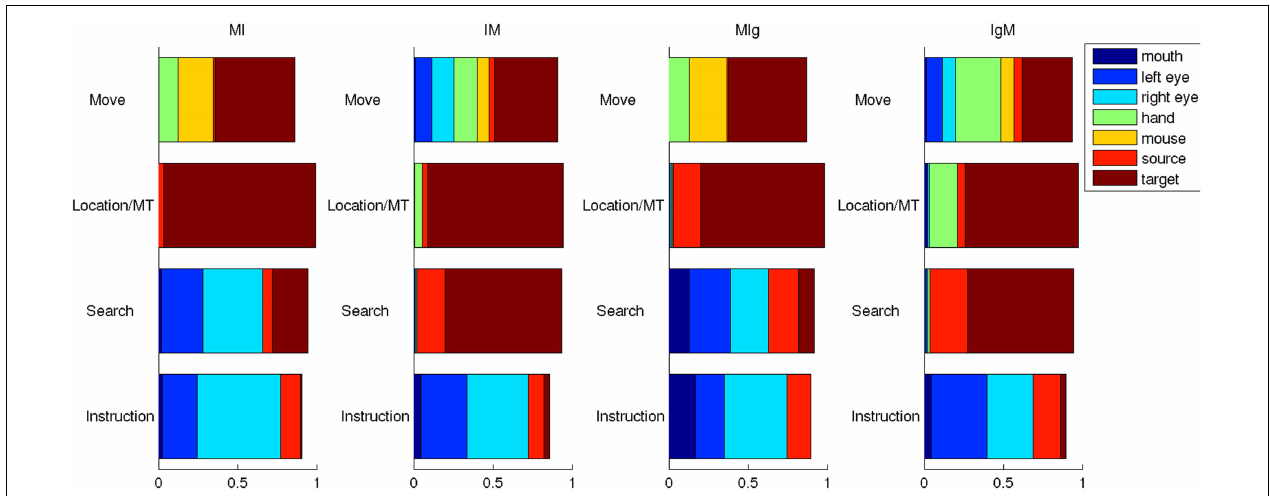
FIGURE 4 | Distributions of referent subject’s gaze toward ROIs according to phase (rows) and condition (columns). During search, Manipulator looks at Informer’s eyes, while Informer looks at target blocks to identify the named cube.